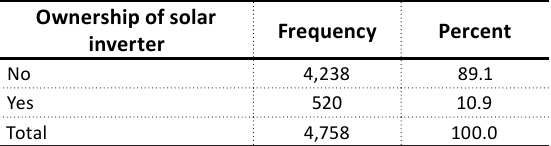
Table 16. Ownership of solar inverter